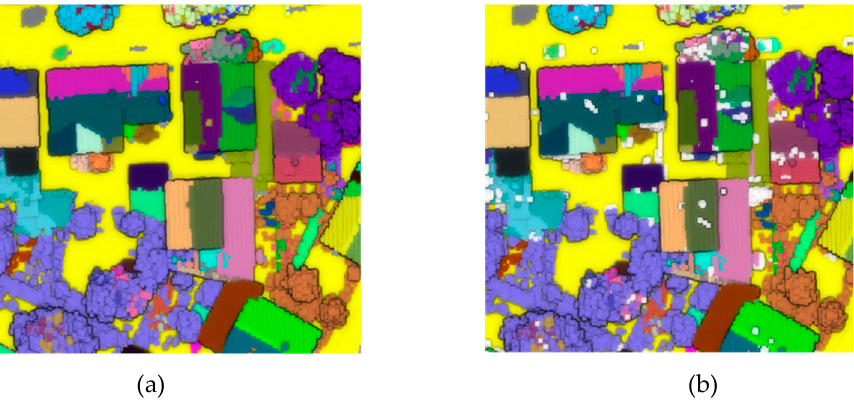
Figure 6. Multiple primitives to split point clouds. ( a ) Planar segments and semantic segments. ( b ) Segments and points.